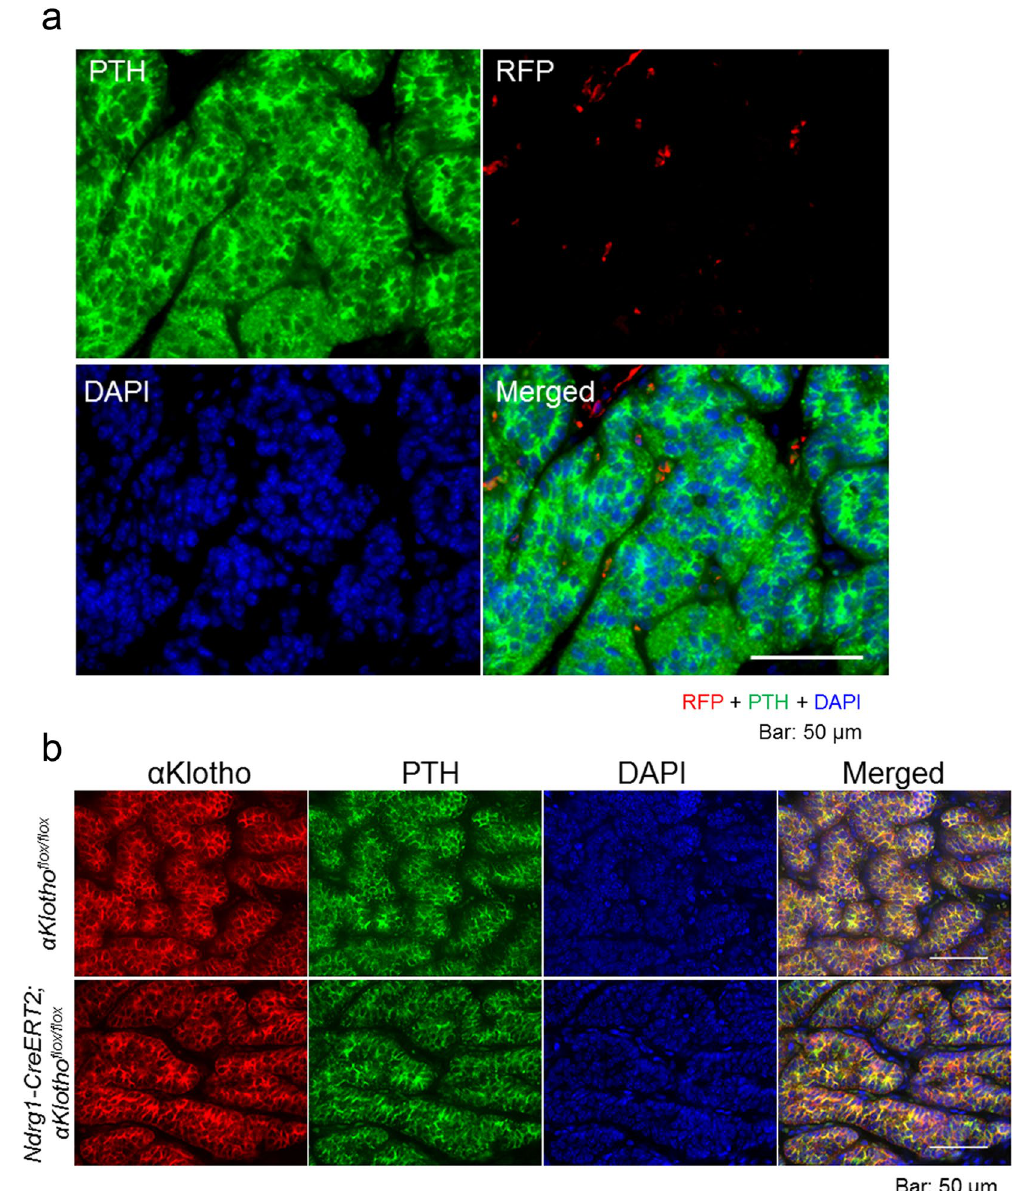
Figure 4. No expression of Ndrg1-CreERT2 in the parathyroid glands. ( a ) Cre expression study in the parathyroid glands of Ndrg1-CreERT2;tdTomato mice at 3 weeks after tamoxifen treatment. Parathyroid sections were immunostained for parathyroid hormone (PTH, green) and RFP (red), and counterstained for cell nuclei with DAPI (blue). Cre was not expressed in PTH-positive parathyroid cells. ( b ) α Klotho expression study in the parathyroid glands of Ndrg1-CreERT2; α Klotho flox / flox mice and α Klotho flox / flox control mice at 3 weeks after tamoxifen treatment. Parathyroid sections were immunostained for α Klotho (red) and PTH (green), and counterstained for cell nuclei with DAPI (blue). α Klotho was expressed equally in PTH-positive parathyroid cells of both mouse strains. Scale bars: 50 μ